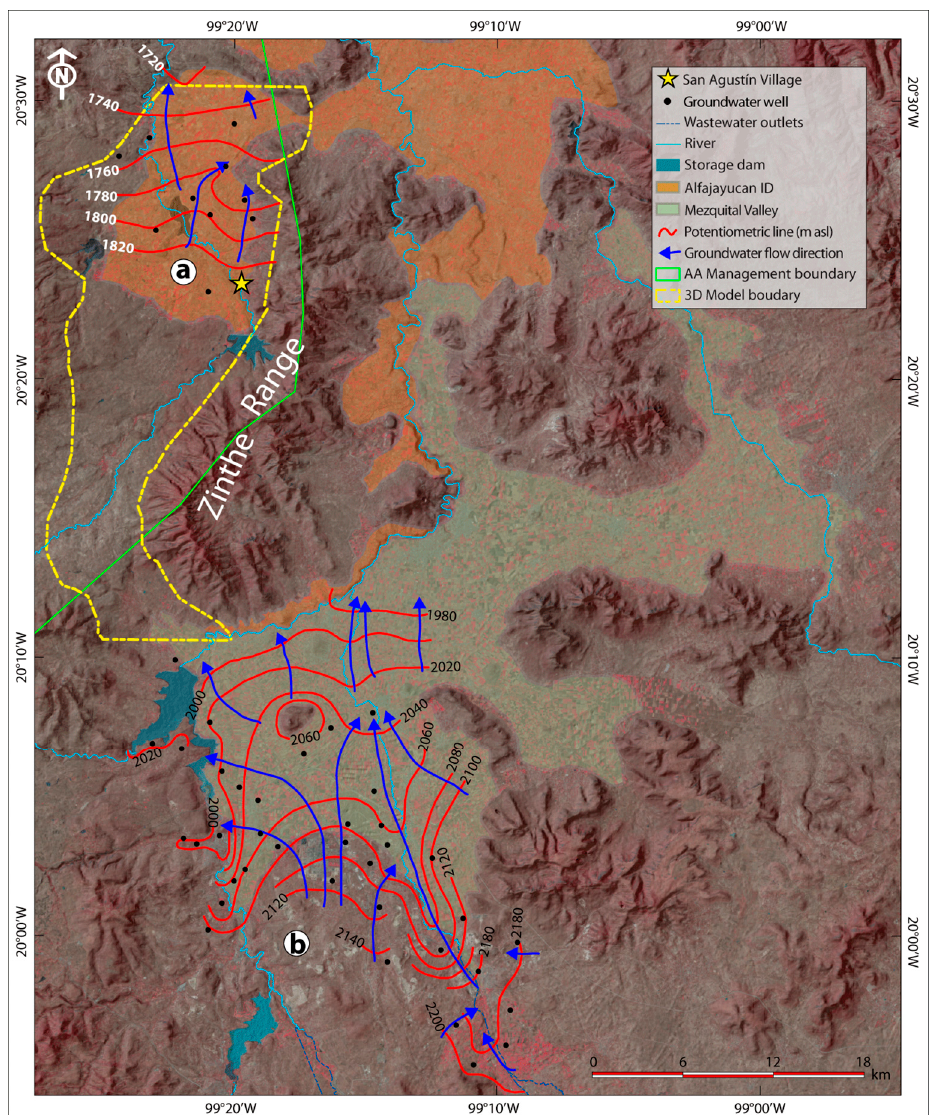
Figure 10. Groundwater flow net in ( a ) the Alfajayucan aquifer for 2012 (adapted from [53]); and ( b ) the Mezquital Valley aquifer for 2007 (adapted from [52]). ID: Irrigation district, AA: Alfajayucan aquifer.